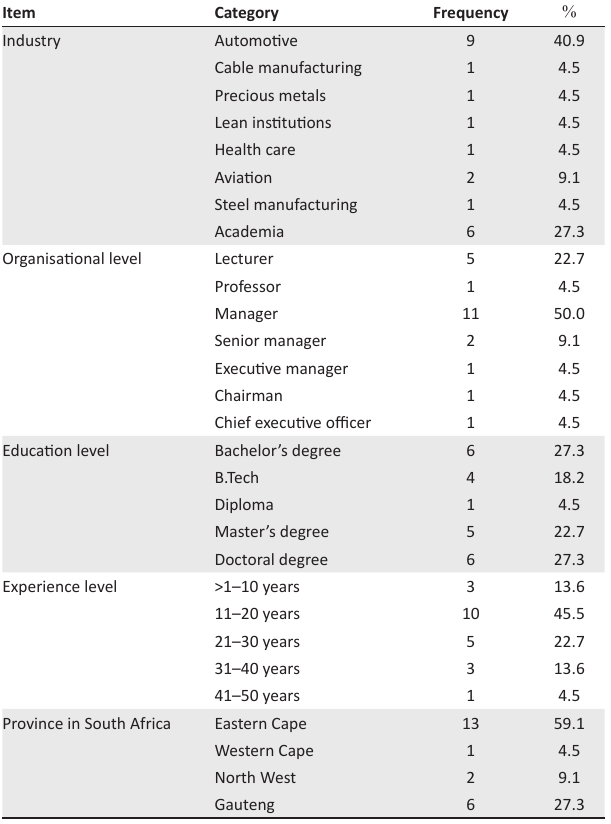
TABLE 2: Characteristic of the sample.